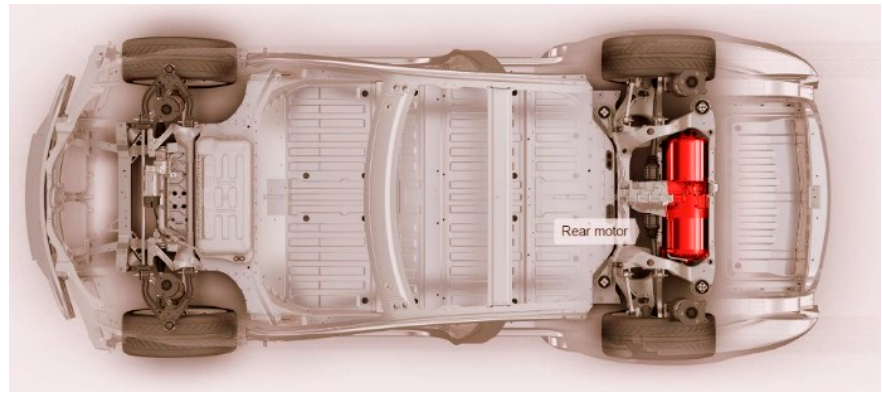
Figure 12. Tesla Model S, rear wheel drive configuration [22,24]. (Reprint with permission [24]; 2017, Tesla.)